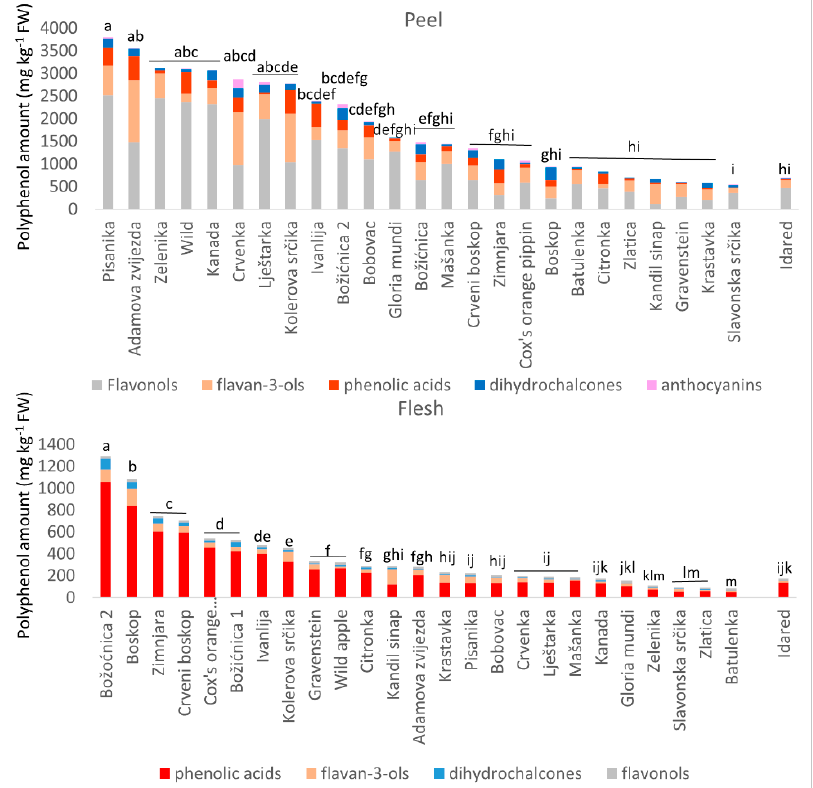
Figure 2. The amount of subgroup of polyphenols (mg kg − 1 FW) in the peel and flesh of apples. Only the amount of total polyphenols was analyzed with post-hoc Tukey test to see possible di ff erences between varieties (a–m refers to the results of the conducted Tukey